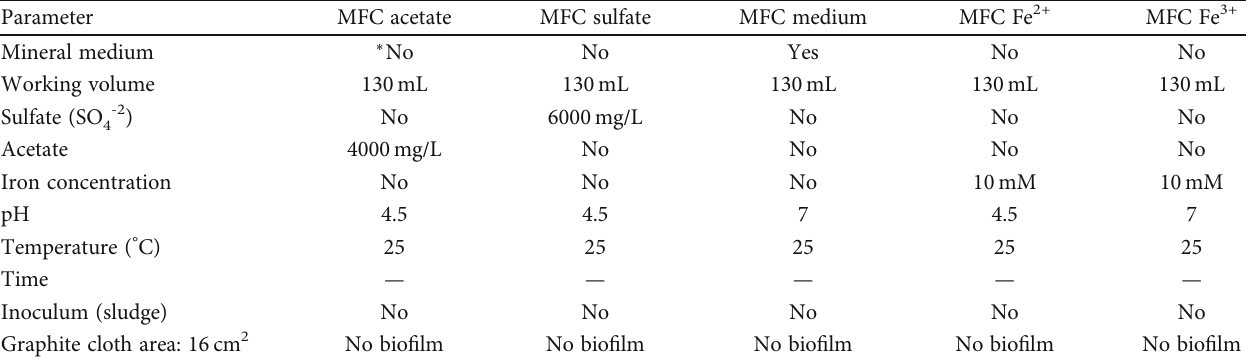
Table 2: Operation conditions for the MFC that served as controls in order to evaluate the cyclic voltammetry (CV) determinations of each